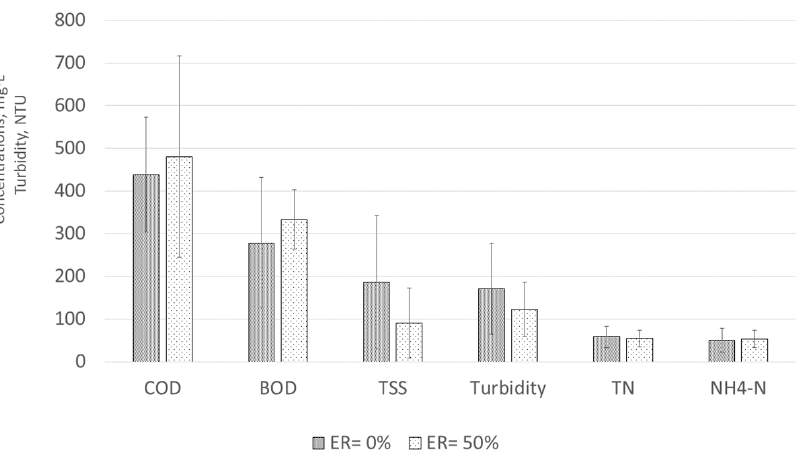
Figure 2. Average concentrations of conventional parameters for the periods of 0% effluent recirculation and 50% effluent recirculation All units in mg · L − 1 , except turbidity (NTU). The error bars are standard deviation values.